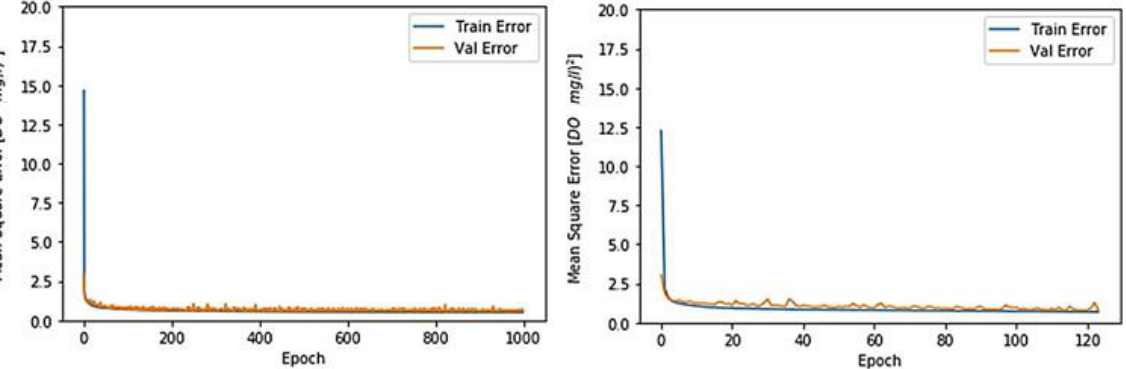
Figure 12. Mean absolute error (Toichio station, structure 4-32-32-1).